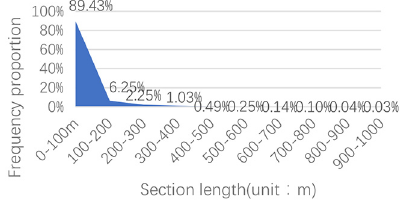
distribution of the length of the